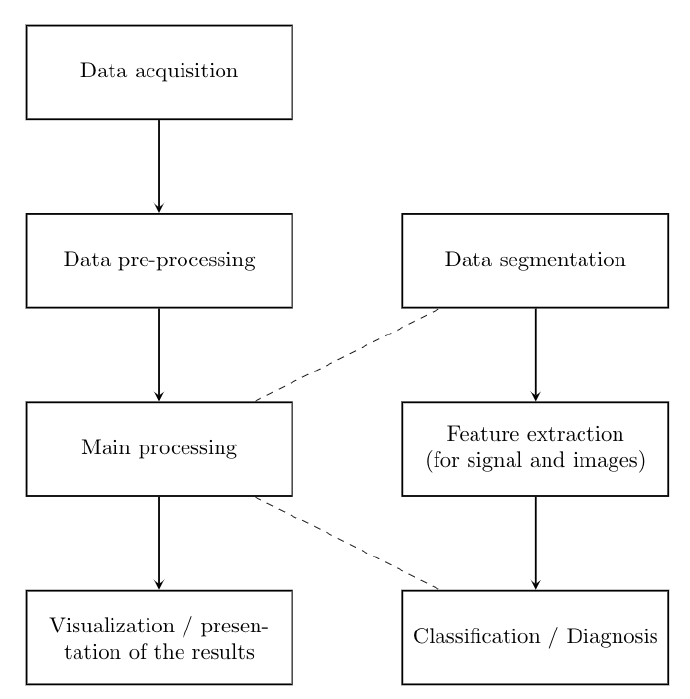
Figure 1. The general structure of a computer-aided diagnosis